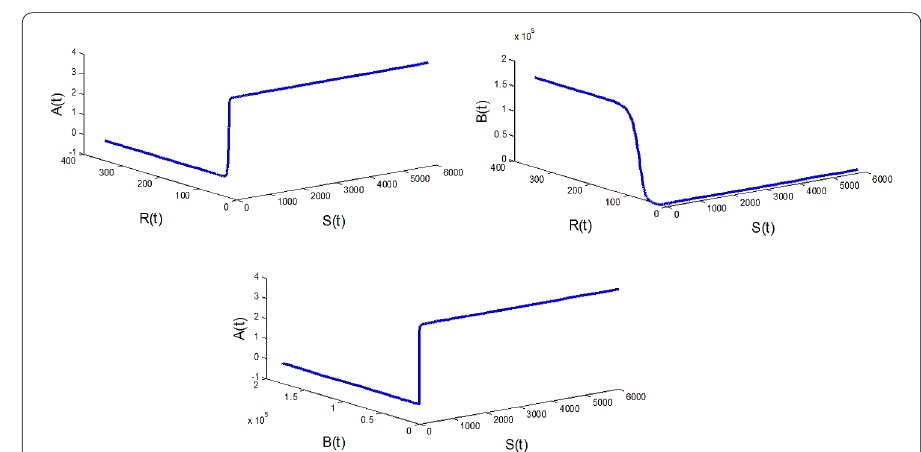
Figure 4 Three-dimensional phase portraits of the deterministic